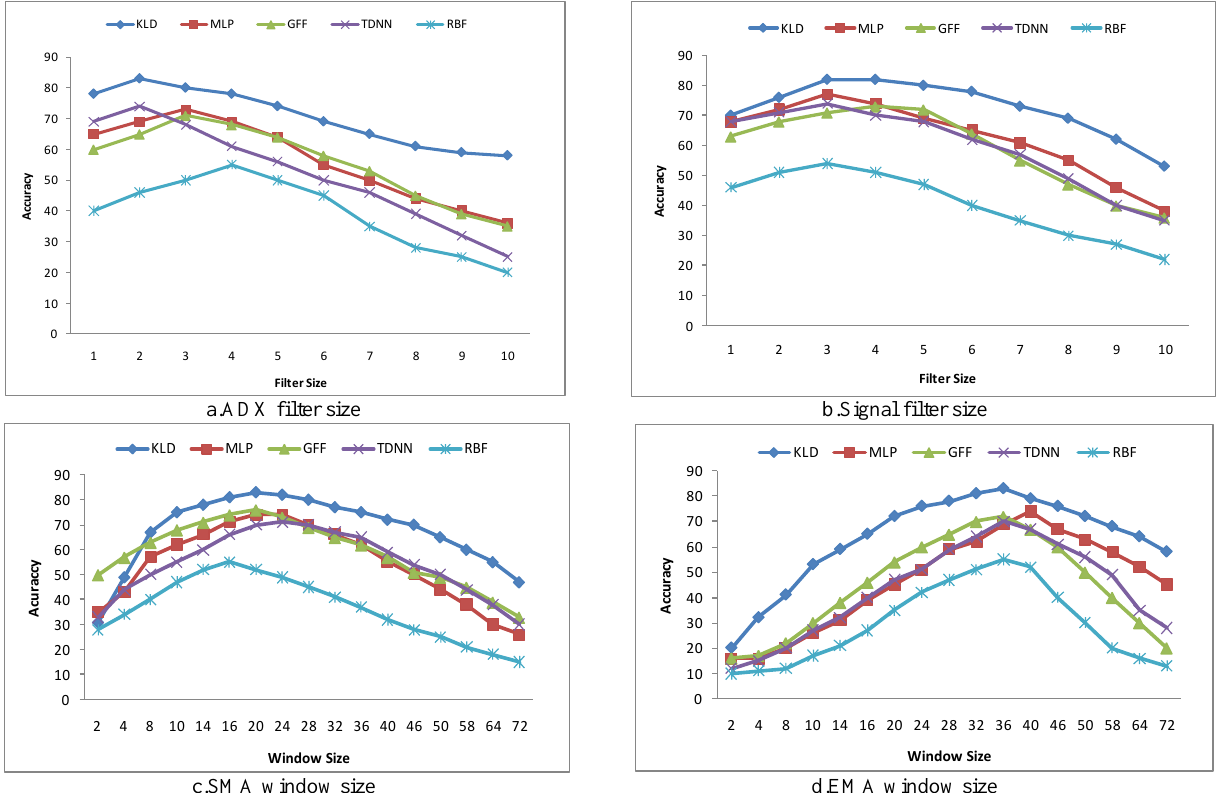
Fig. 8. Sensitivity results for data set parameters using MS